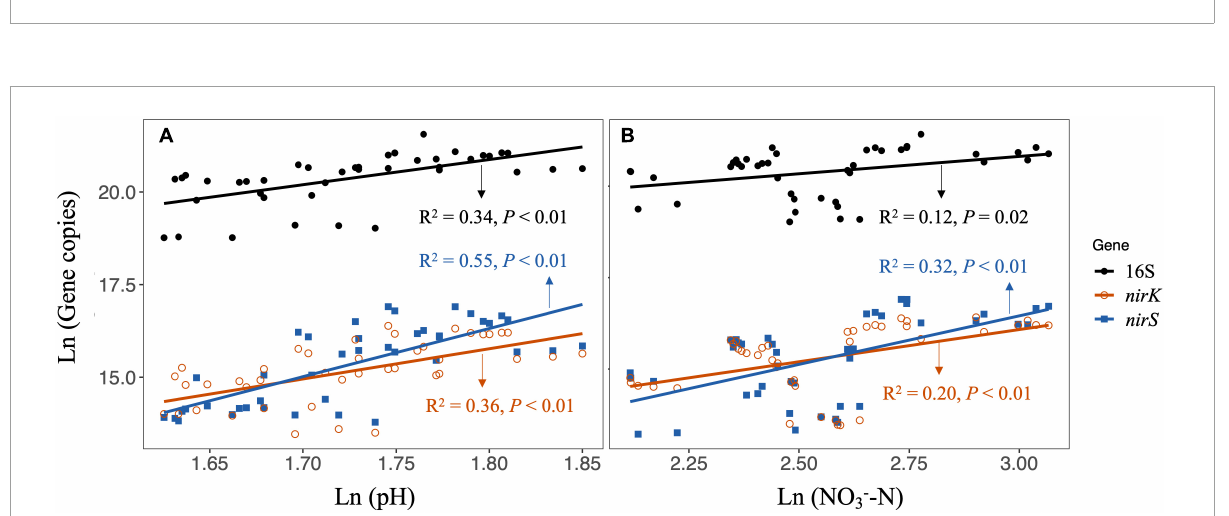
FIGURE2 Linear regressions for testing the relationship between soil properties and gene copy numbers of 16S, nirK, and nirS under N additions [ (A) including CK, LN, and HN treatment] and P additions [ (B) including CK, LP, and HP treatment]. LN, low N; HN, high N; LP, low phosphorous; HP, high phosphorous; CK, control.